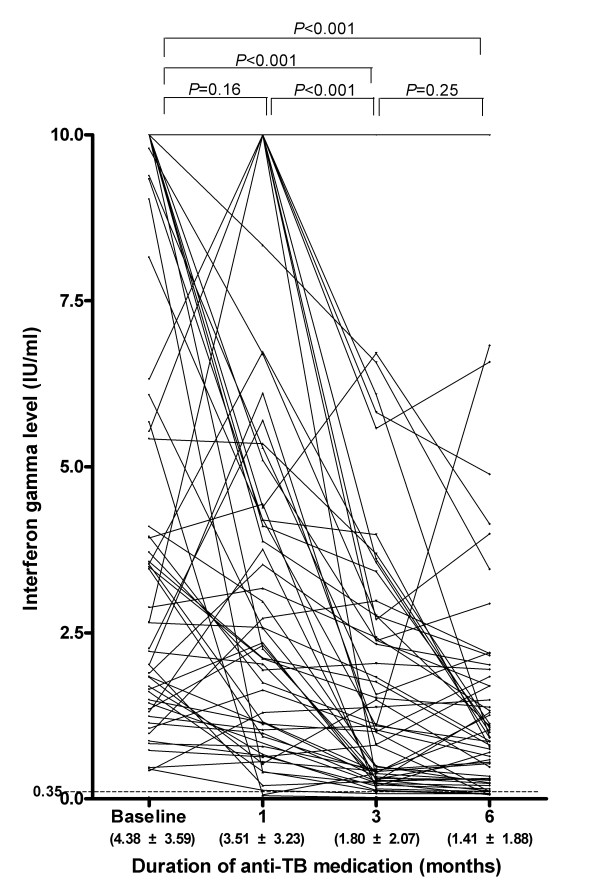
The change in the IFN-γ level during successful anti-TB treatment.